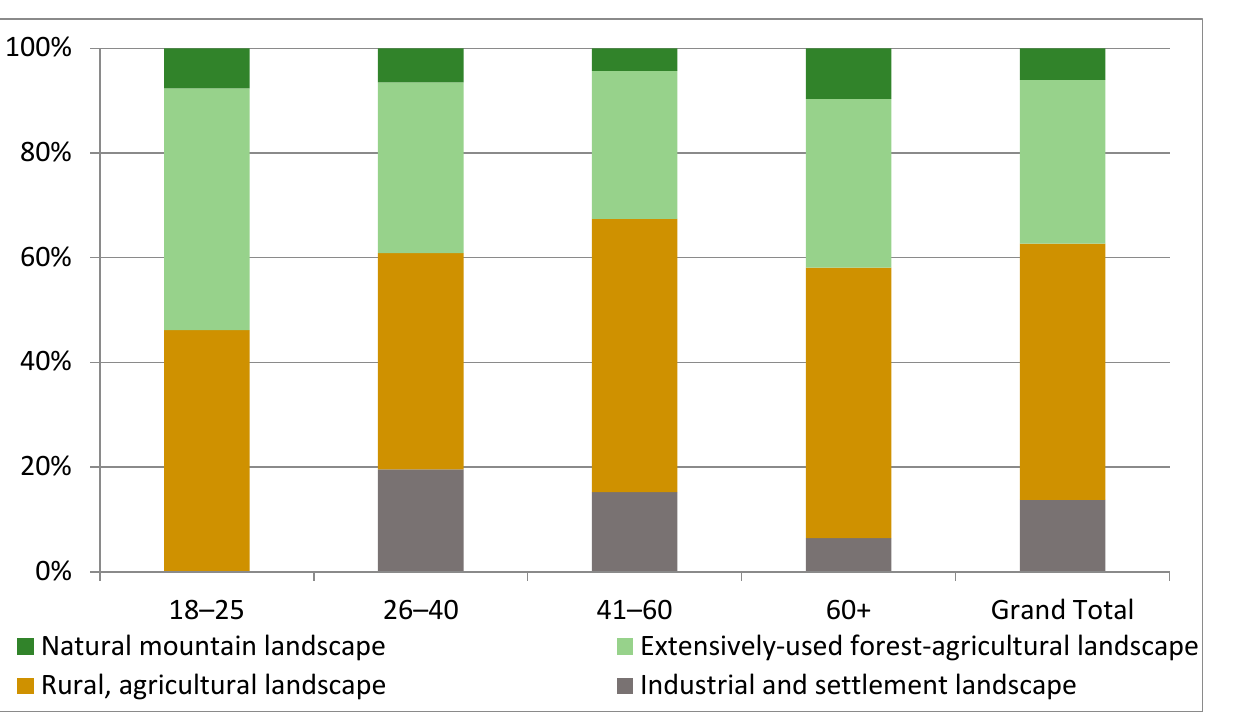
Figure 4. Specification of the most characteristic types of Slovak landscape according to the age of respondents.